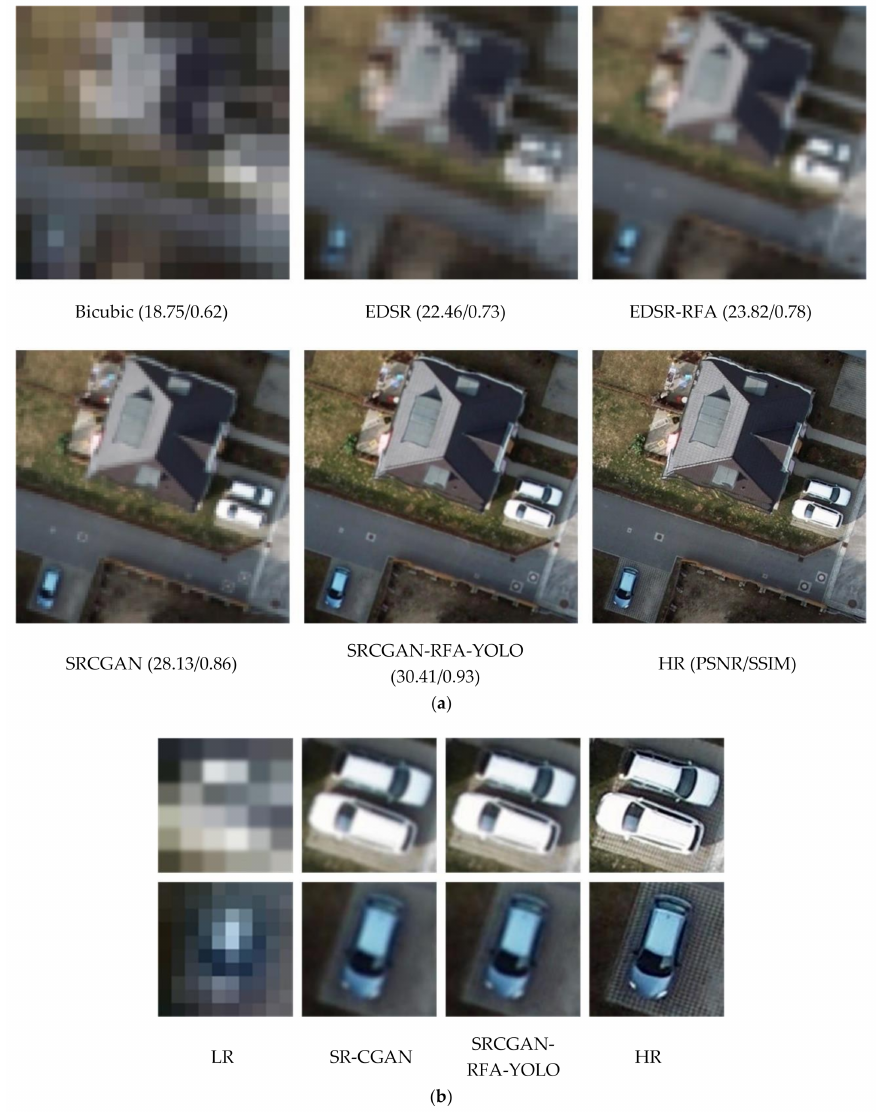
Figure 9. Comparison of the results for SR with a scale factor of 16 using EDSR-RFA, SR-CGAN, and SRGAN-RFA-YOLO. The LR version is 80 cm/pixel while the HR image is 5 cm/pixel. ( a ) SR images of different methods and their image quality metrics in terms of PSNR and SSIM; ( b ) zoomed sections for two different